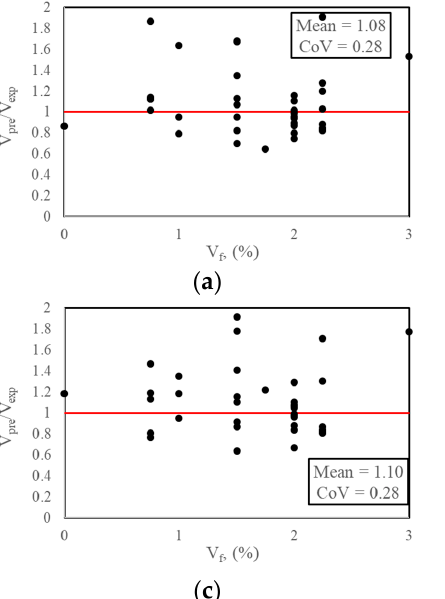
Figure 7. Comparison between predicted and experimental values of shear strength. ( a ) ANN; ( b ) SVR; ( c ) XGBoost; ( d ) Qi et al.; ( e ) Ahmad et al.; ( f ) CECS 38:2004; ( g ) Sharma et al.